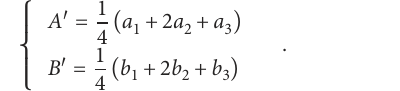
FIGURE 3 Membership functions of TFNs of linguistic variables in Table 1 .